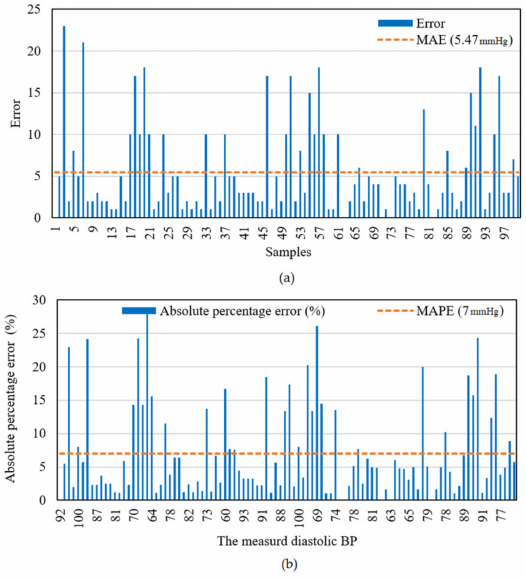
Figure 8. Error measurements of the diastolic BP readings ( a ) an error with the number of samples ( b ) APE (%) relative to the systolic BM